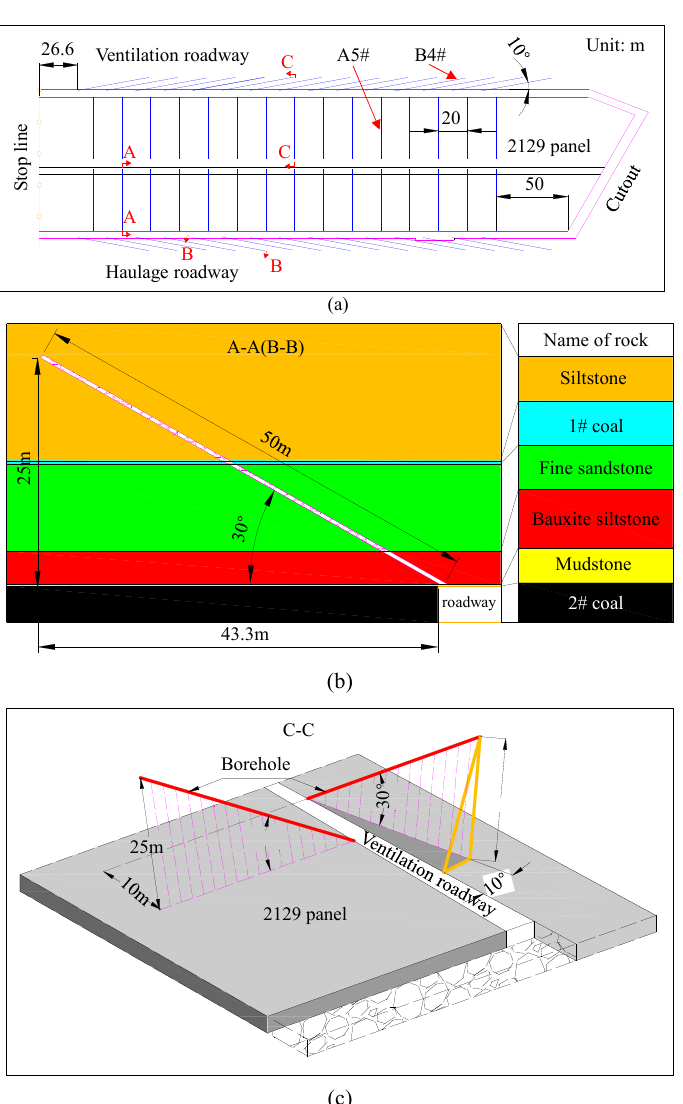
Figure 6. Layout of hydraulic fracturing boreholes: ( a ) layout of hydraulic fracturing boreholes; ( b ) section A–A and section B–B; ( c ) three-dimensional diagram of section